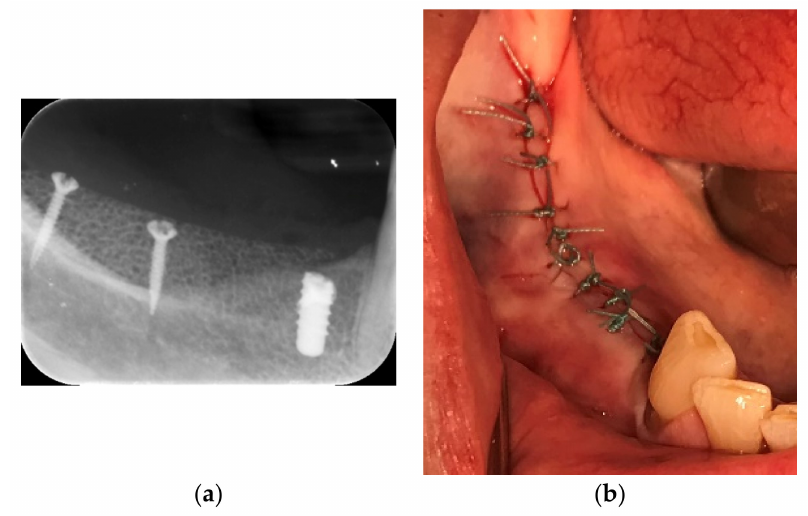
Figure 8. Postoperative radiograph ( a ) and clinical condition after flap closure ( b ).